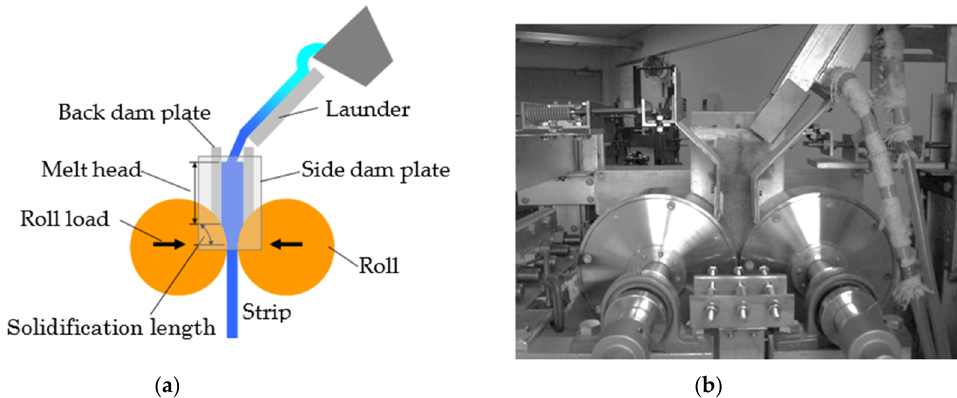
Figure 3. ( a ) Schematic illustration of a vertical-type high-speed twin-roll caster and ( b ) photo- graph of near rolls. Roll diameter is 300 mm and width is 100 mm. of near rolls. Roll diameter is 300 mm and width is 100 mm.